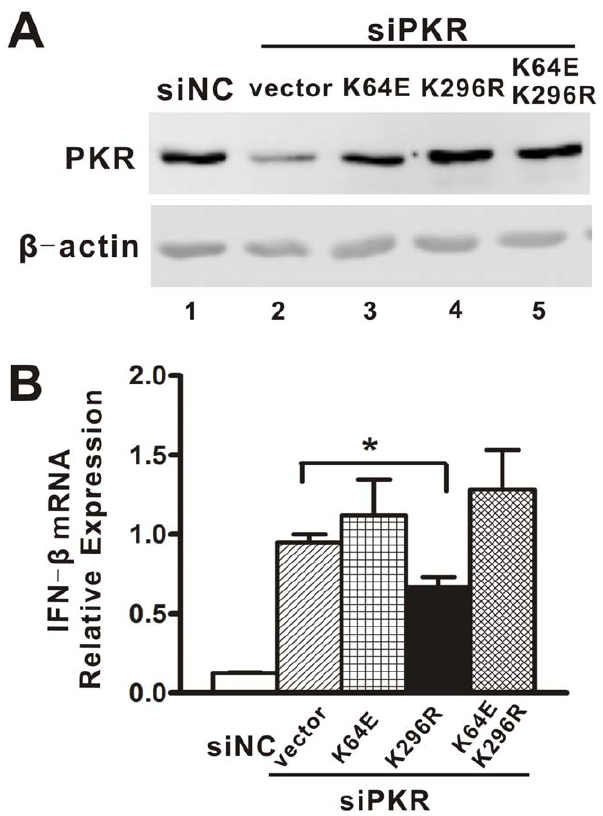
Figure 4. The dsRNA binding activity of PKR was important for downregulation of IFN induction. A549 cells were transfected with pcDNA6, pcDNA6-K64E, pcDNA6-K296R or pcDNA6-K64EK296R fol- lowed by siNC or siPKR1 transfection. Cells were then harvested for Western blot analysis (A). A549 cells transfected with different PKR mutants and siPKR1 were stimulated by DENV2 infection. Total cellular RNA was harvested for real-time PCR analysis (B). Data are shown as the mean 6 SEM and represent for at least three independent experiments. *p , 0.05.